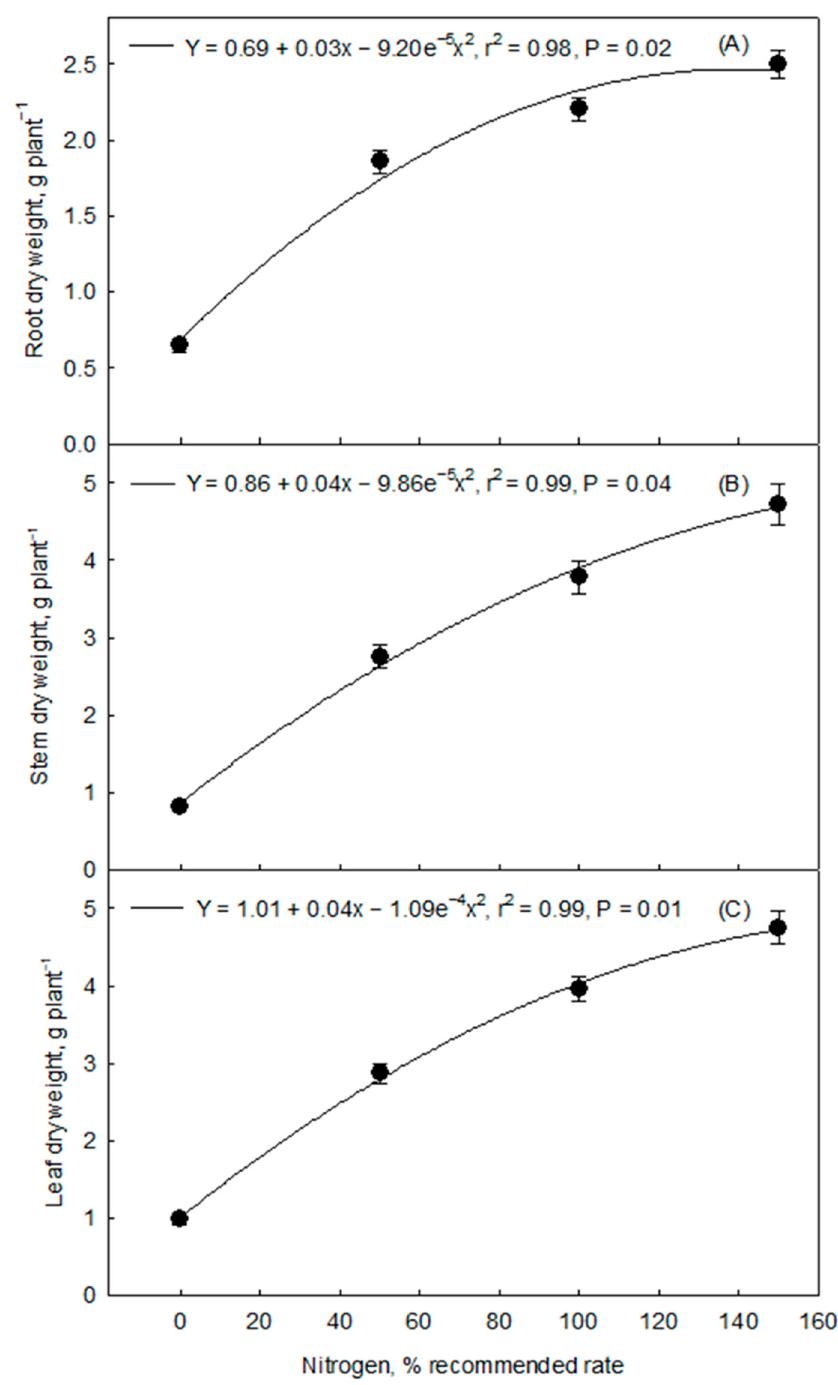
Figure 6. Nitrogen treatment effect on root ( A ), stem ( B ), and leaf ( C ) dry weights of cotton at 60 days after planting. Data are means ± Standard error ( n = 64plants in total for fourreplications and two runs).